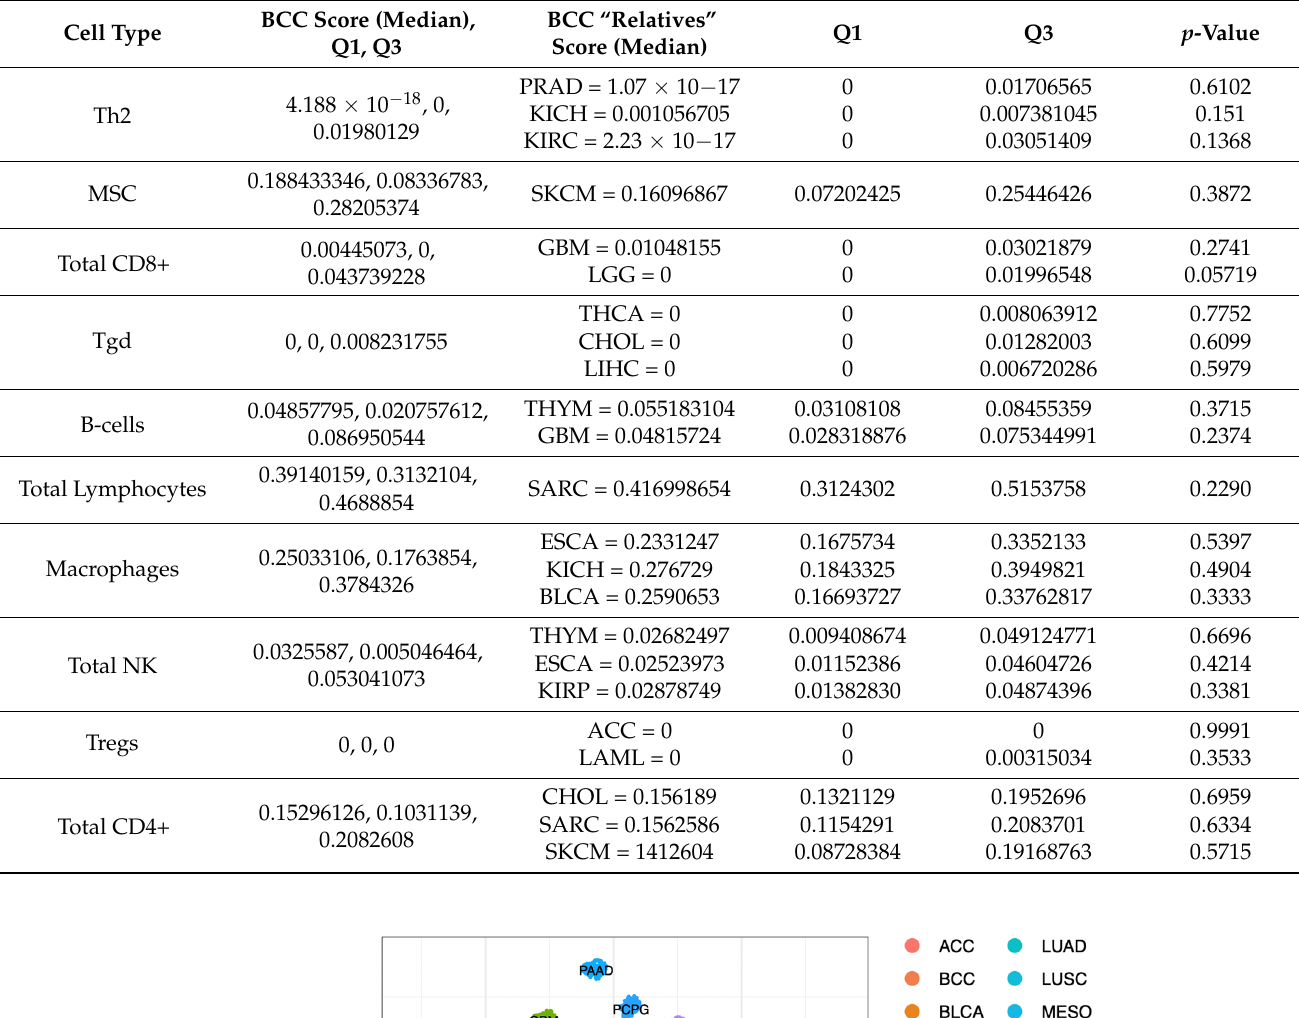
Table 1. Summary of the top three significant (if available) closest BCC “relatives” by cell type.